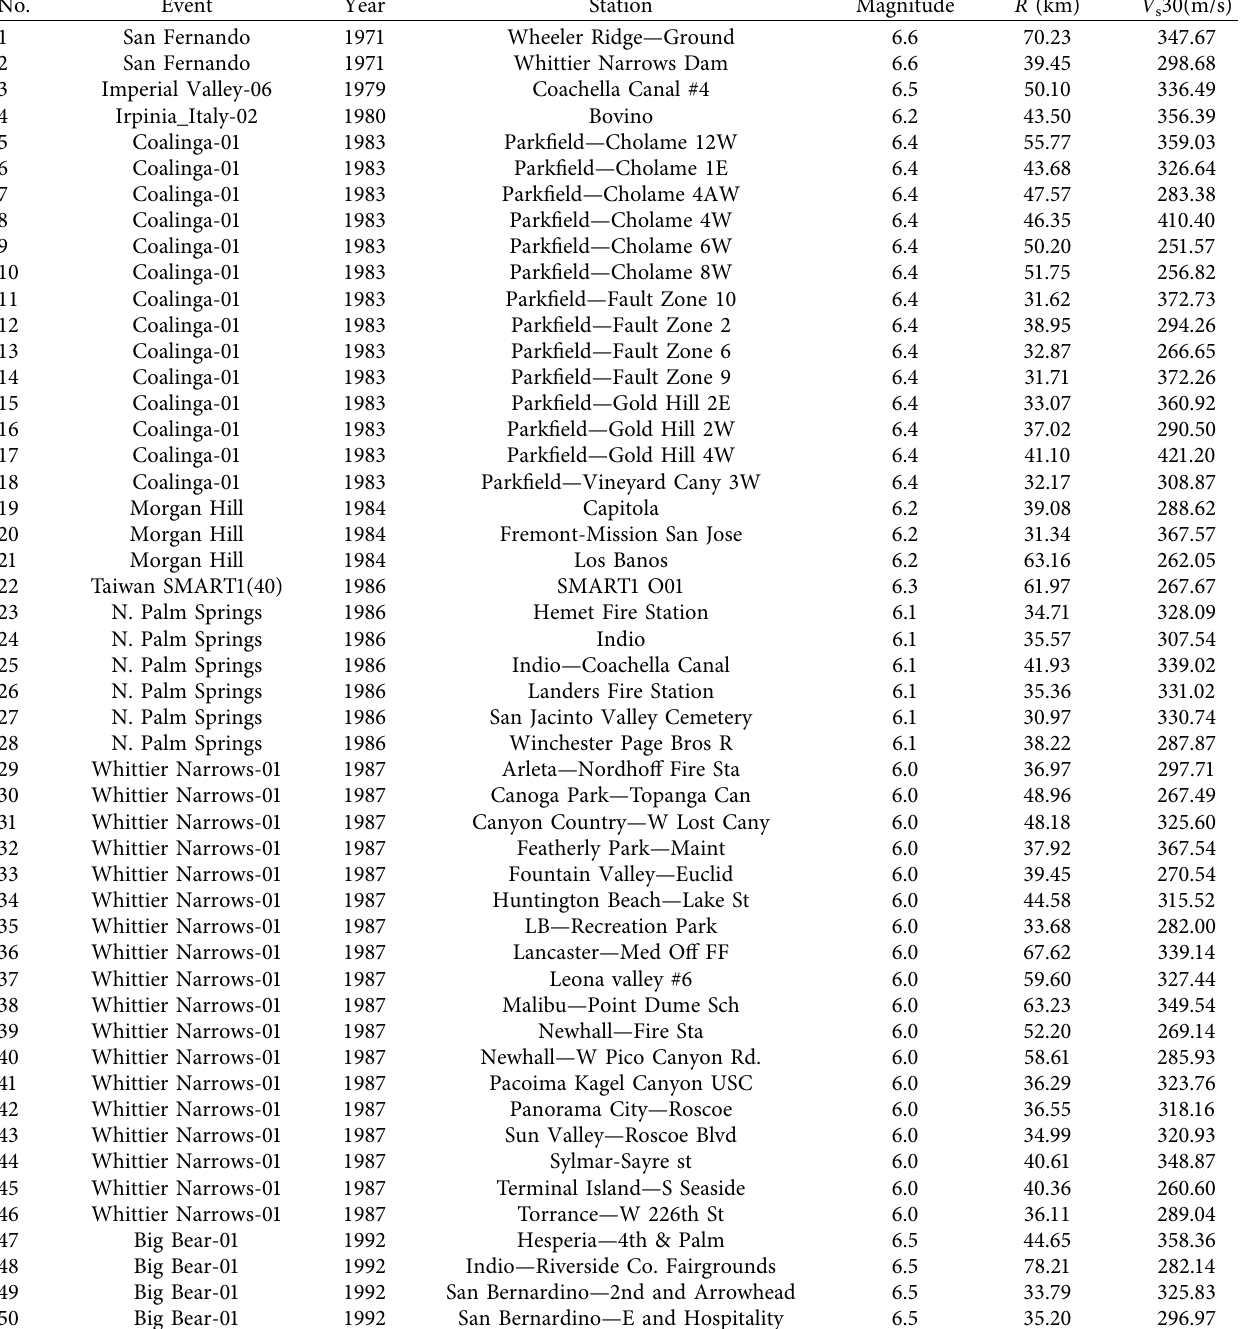
Table 3: Selected record